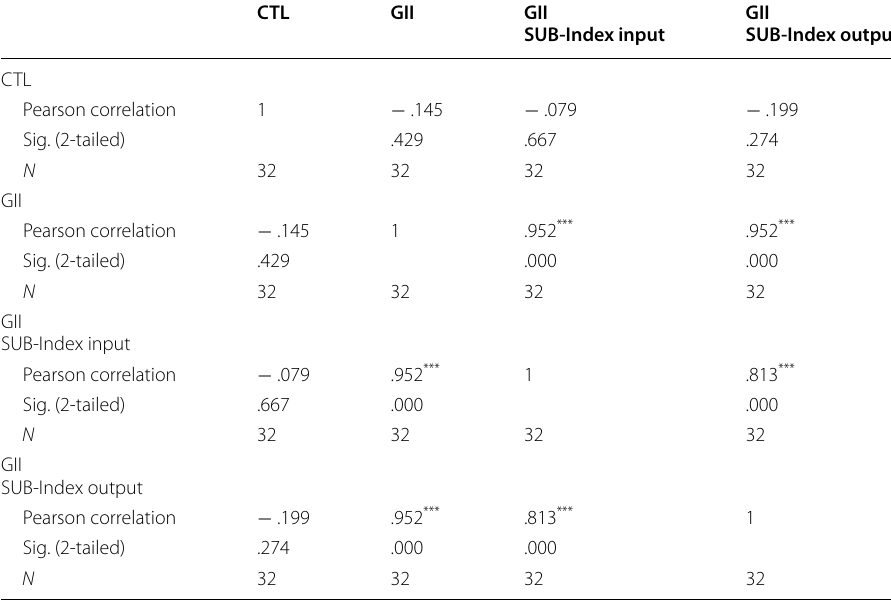
Table 4 Correlations data Gelfand et